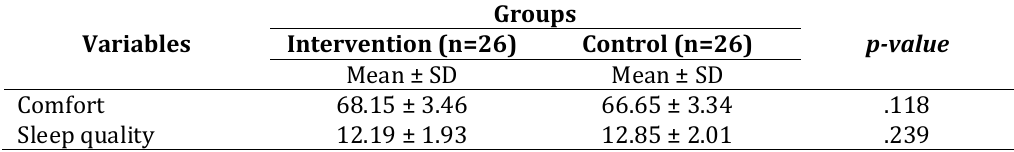
Table 2 Homogeneity test between the two groups on the pre-intervention